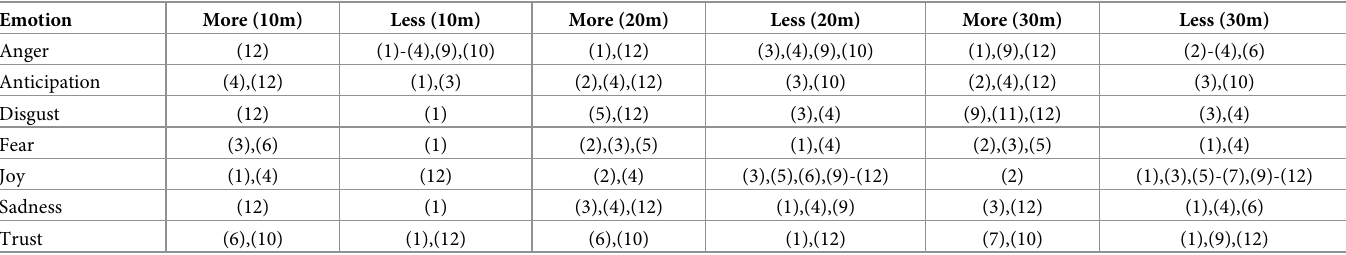
Table 5. The categories of locations which showed significant differences (p < 0.05) in the display of emotions at three different distance levels in San